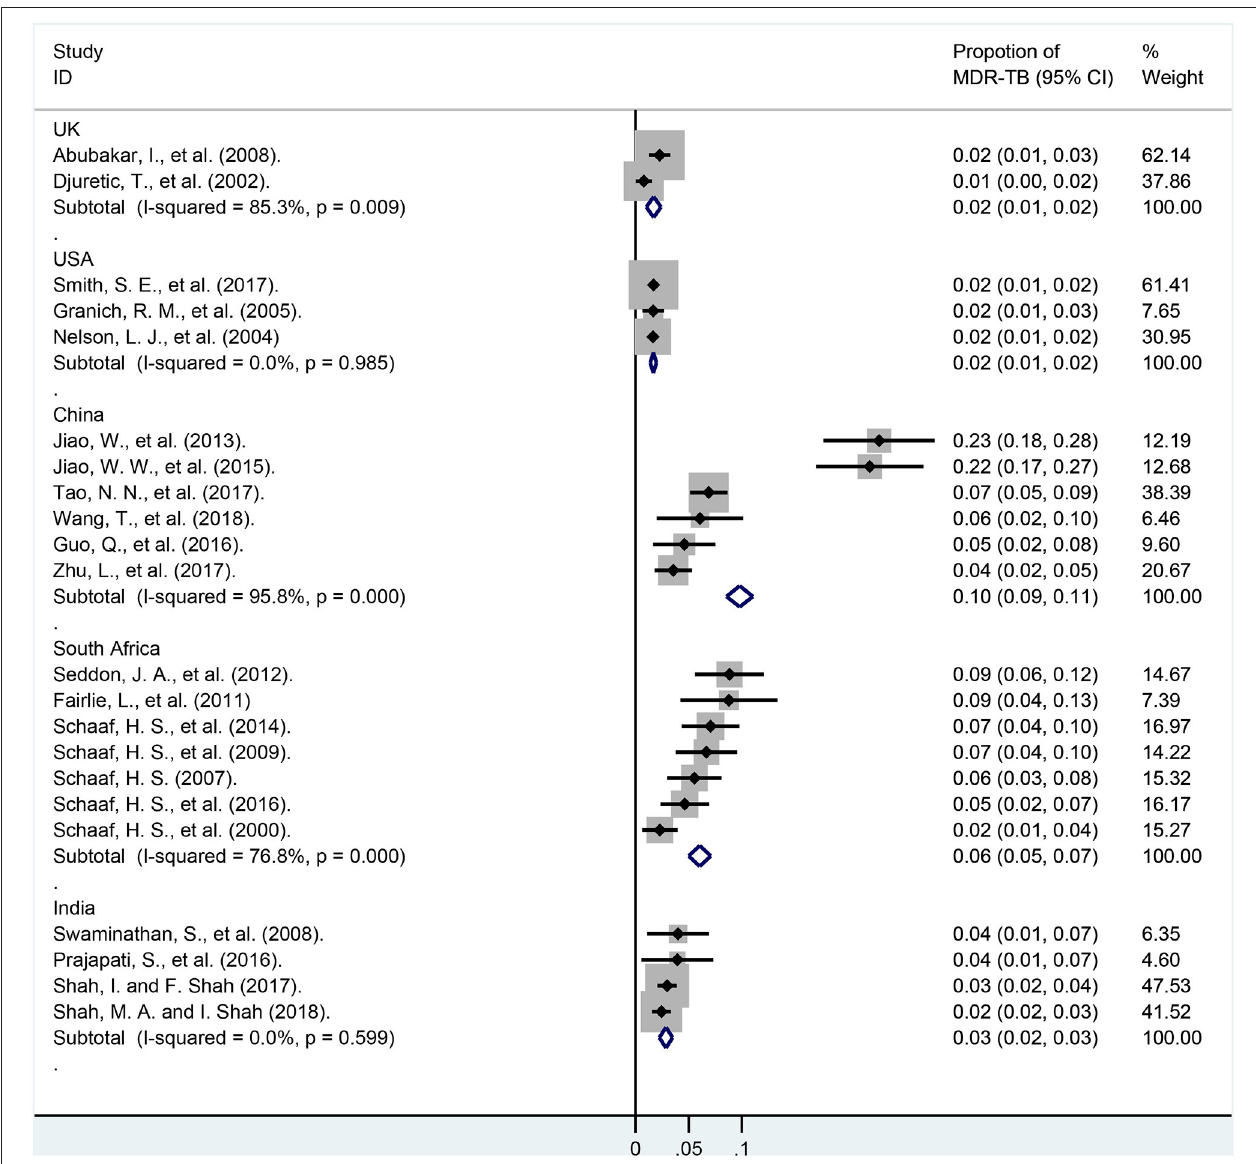
FIGURE 6 | Forest plots for multidrug-resistant tuberculosis ratios in different country. MDR-TB, multidrug resistant tuberculosis; Horizontal lines represent the 95% CIs around the point estimates for each study and the gray shaded areas are proportional to the weight given to each